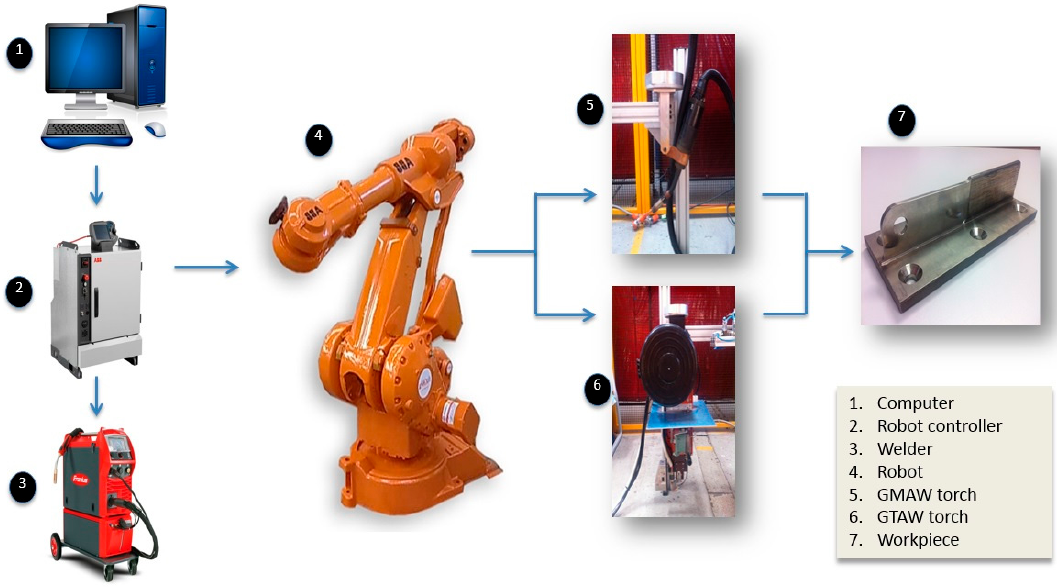
Figure 1. Schematic diagram of the developed experimental WAAM system.